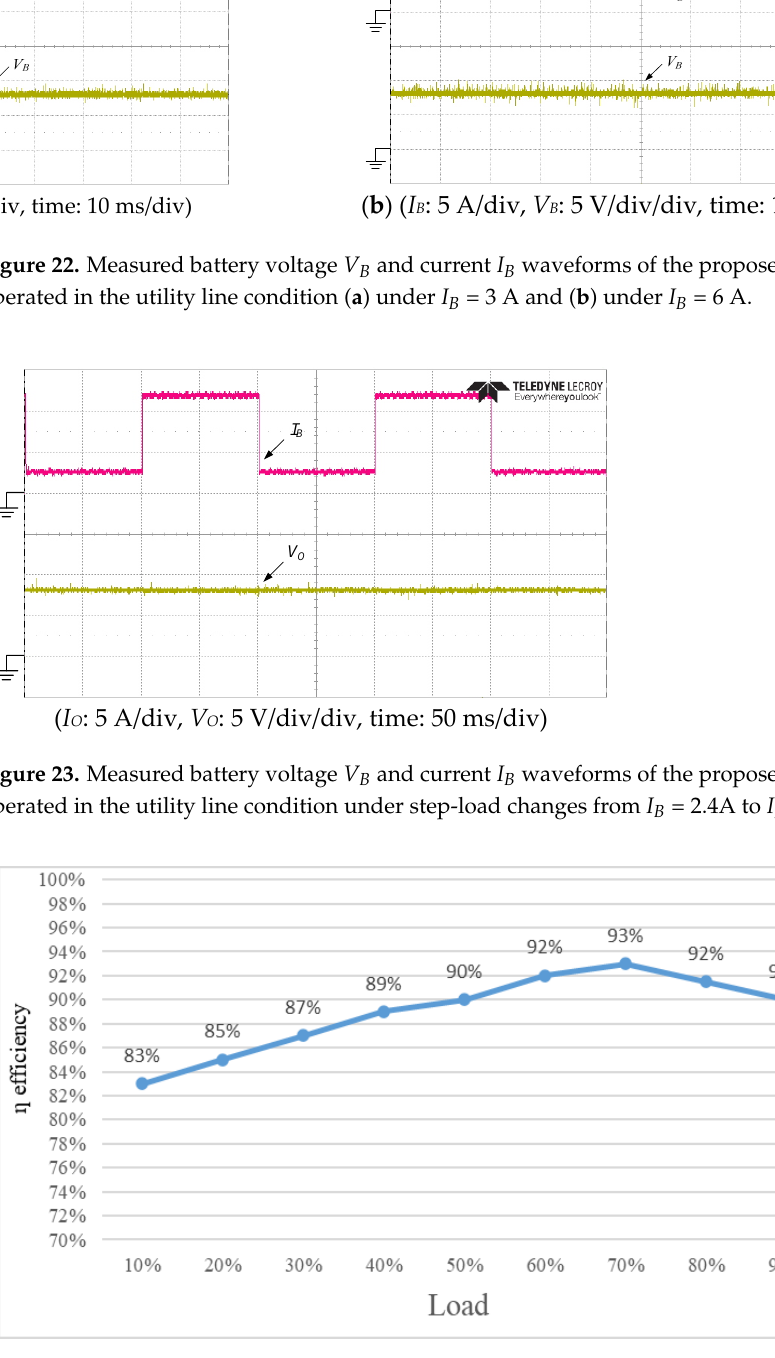
Figure 24. Conversion efficiency curve of the proposed hybrid converter operated in the utility line condition from light loads to heavy loads.